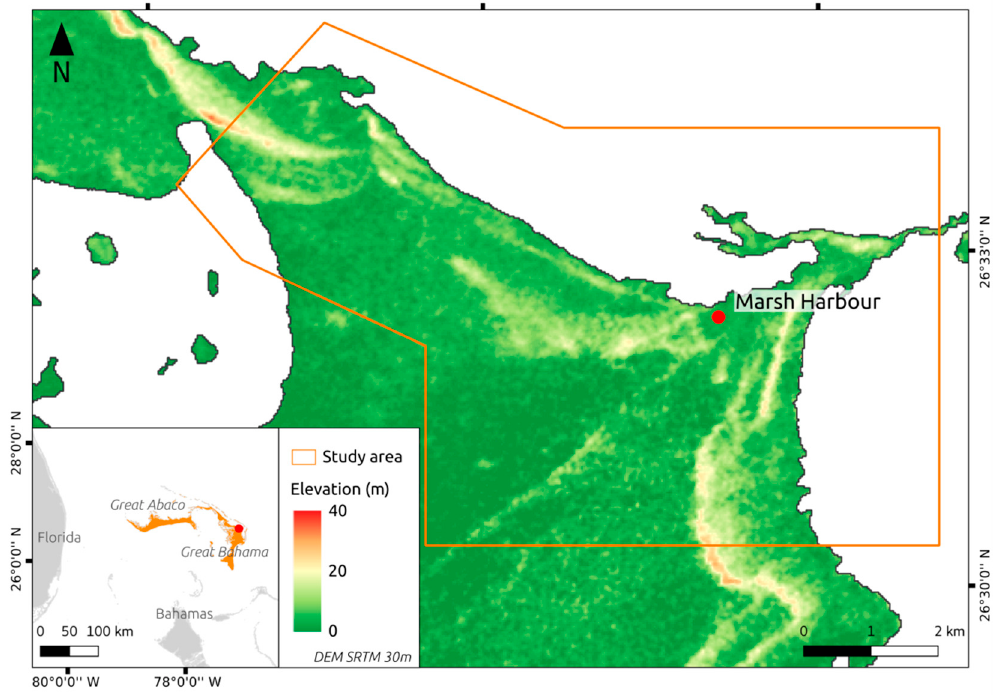
Figure 1. Localization map of Great Bahama and Great Abaco with elevation of study area. Altimetry from NASA Shuttle Radar Topography Mission Digital Elevation Model (SRTM DEM).